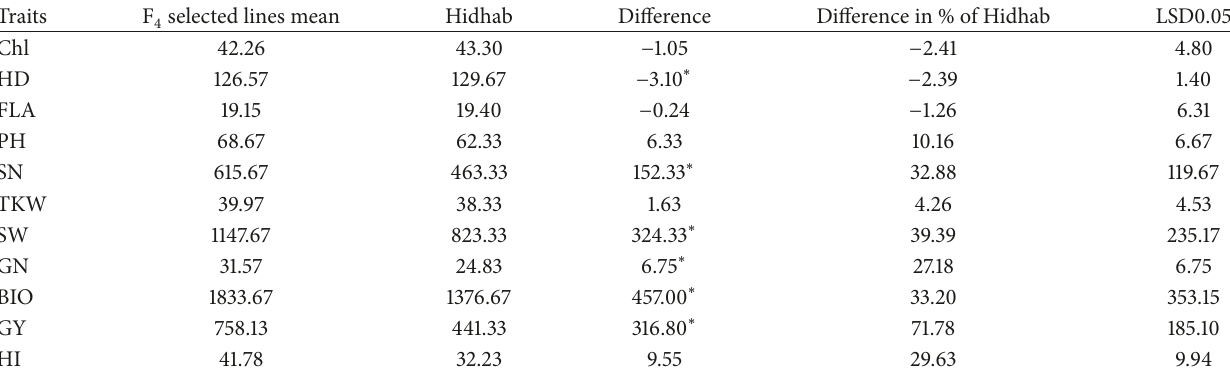
Table 7: Differences of the F 4 selected lines relatively to the standard check Hidhab for the measured traits. Traits F 4 selected lines mean